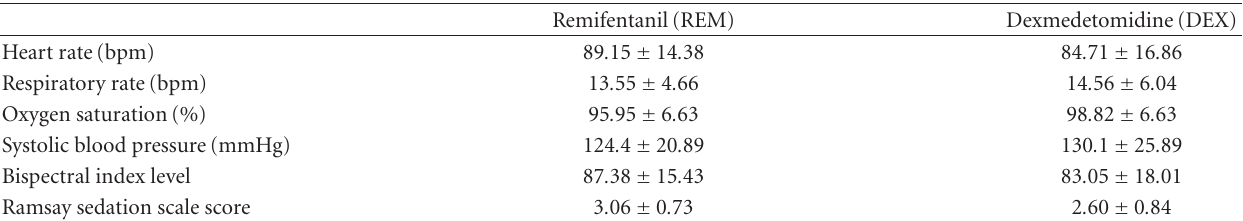
Table 3: Physiologic data of patients in the two groups. Data includes heart rate (bpm), respiratory rate (bpm), oxygen saturation (%), systolic blood pressure (mmHg), bispectral index level, and Ramsay sedation scale